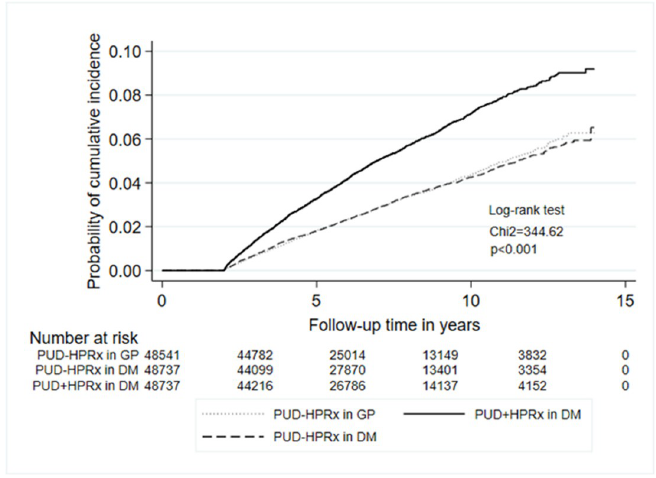
Fig 2. Cumulative incidence of IBD with a two-year washout period. Higher cumulative incidence of IBD in DM patients with peptic ulcer disease with Helicobacter pylori treatment (PUD+HPRx in DM) as compared with the general population with peptic ulcer disease without Helicobacter pylori treatment (PUD-HPRx in general population) and with DM patients with peptic ulcer disease without Helicobacter pylori treatment (PUD-HPRx in DM).